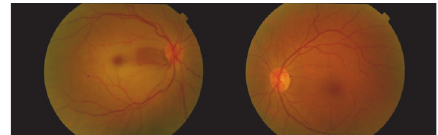
Figure 3: Fundus photographs of the patient after four